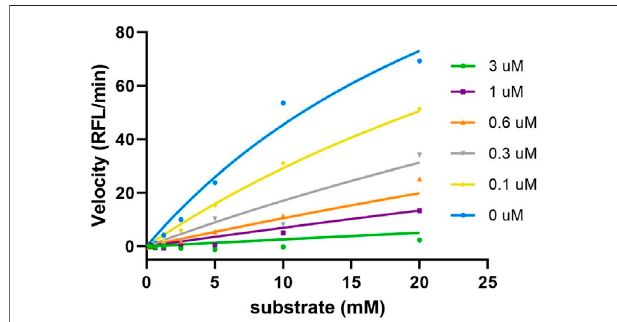
FIGURE 3 | Kinetics studies of inhibition of compound 5. The enzyme activitieswereevaluatedusingvariousconcentrationsofsubstrate(0~20 mM) and inhibitor (0~3 uM). The results were then fi tted into the competitive model using the equation K m, Obs = K m*(1+[I]/ K i), and Y=Vmax*X/( K m, Obs + X) (GraphPad). The K i value was determined as 0.14 μ